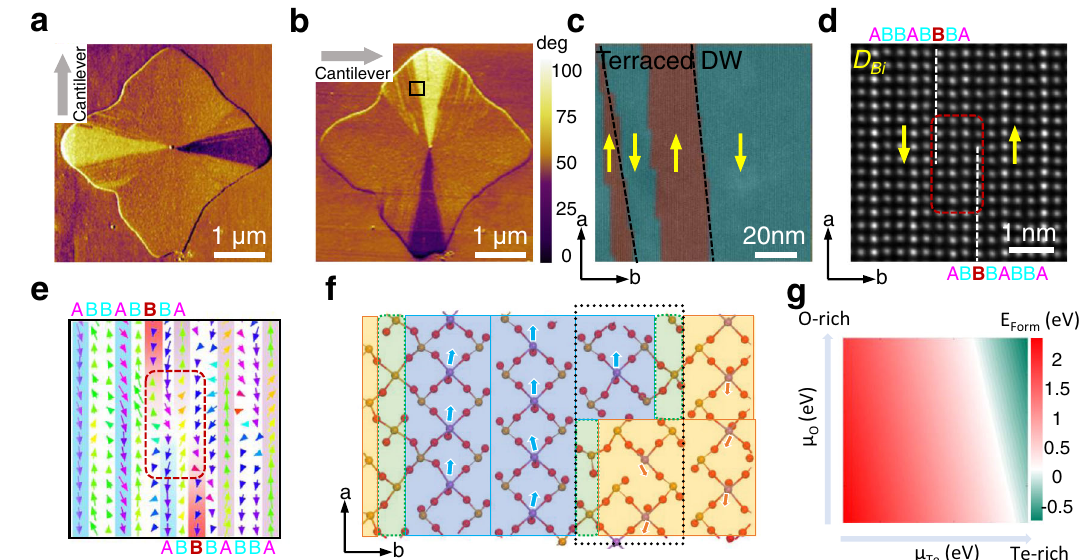
Fig.5|KinkedbufferlayerinducedterraceddomainwallinBi 2 TeO 5 .a , b Lateral PFM images at perpendicular cantilever angle showing fan-shaped domains in Bi 2 TeO 5 . c Zoom-in HAADF-STEM image of the black square in b . d , e Atomically resolved HAADF-STEM image and corresponding polarization distribution at the